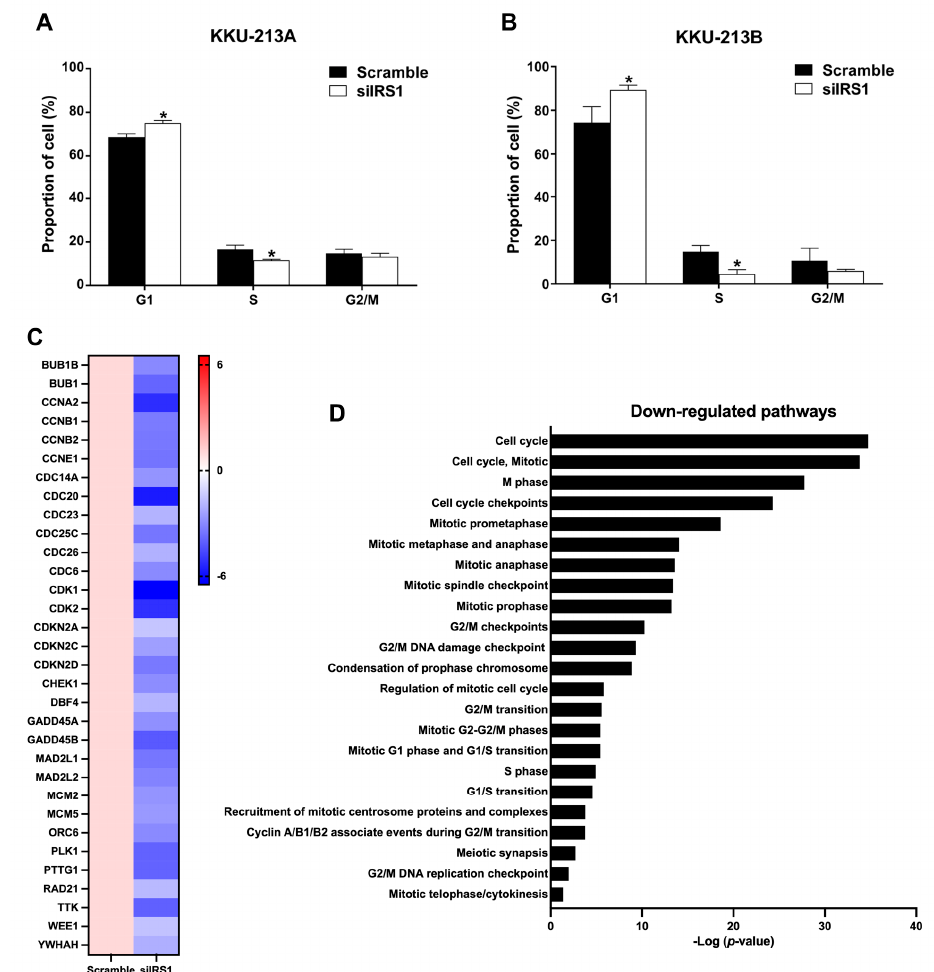
Figure 6. Effect of IRS1 knockdown on cell cycle progression of CCA cell lines. ( A , B ) Percentage of cells at different cell cycle stages after IRS1 knockdown and propidium iodide staining, as detected by flow cytometry. ( C ) Heatmap indicates fold changes of cell cycle-related gene expression in IRS1-silenced KKU-213B cells investigated by RNA sequencing. ( D ) Down-regulated pathways in IRS1 knockdown cells analyzed by Reactome pathway enrichment. * p -value < 0.05 compared to scramble.